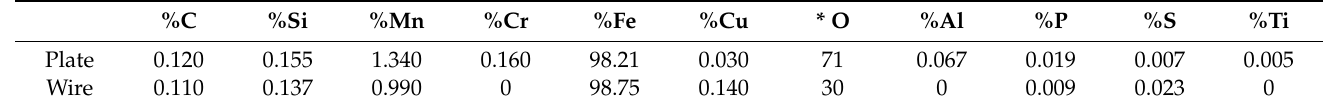
Table 1. Steel base plate and weld wire compositions.